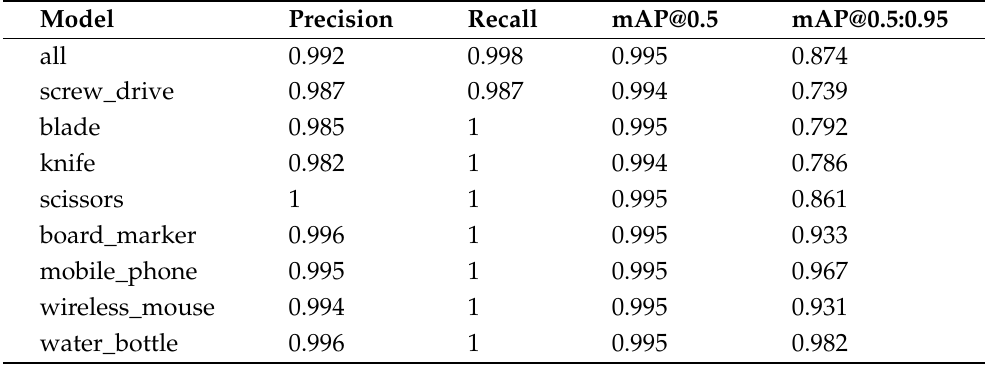
Figure 17. Convolutional feature map visualization.where sub graph ( a – i ): ( x - axis = Epoch and y - axis = Colour intensity ) . Table 4. Performance on each class with